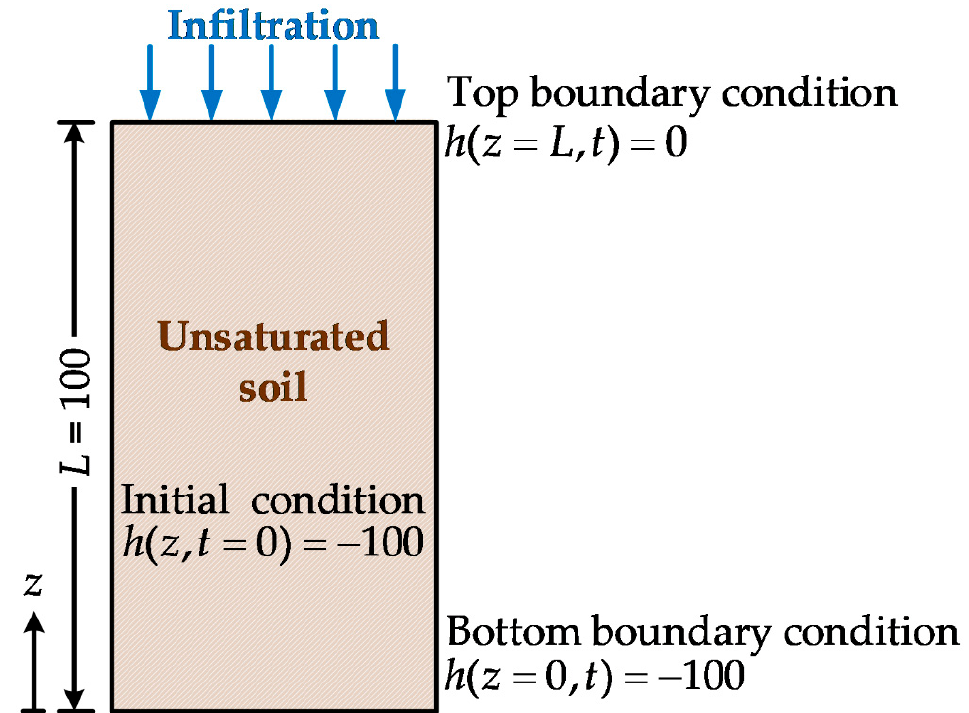
Figure 8. A schematic of one-dimensional Green–Ampt problem.